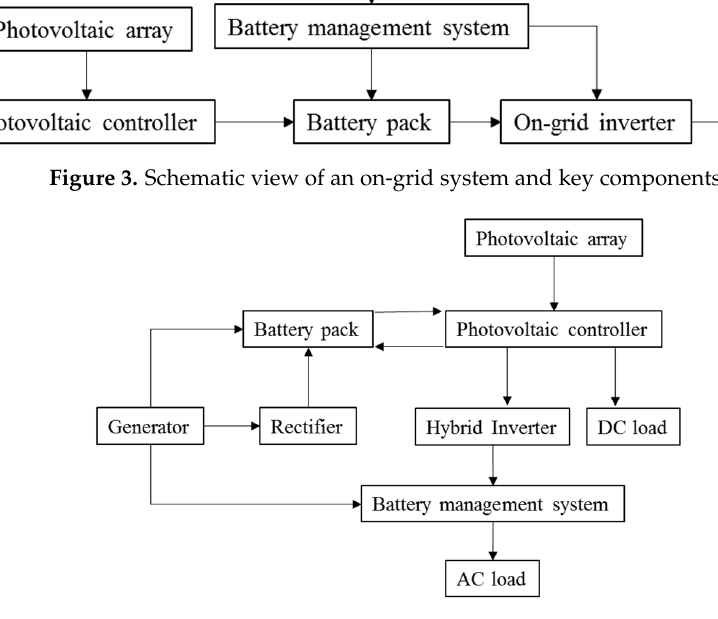
Figure 3. Schematic view of an on-grid system and key components.